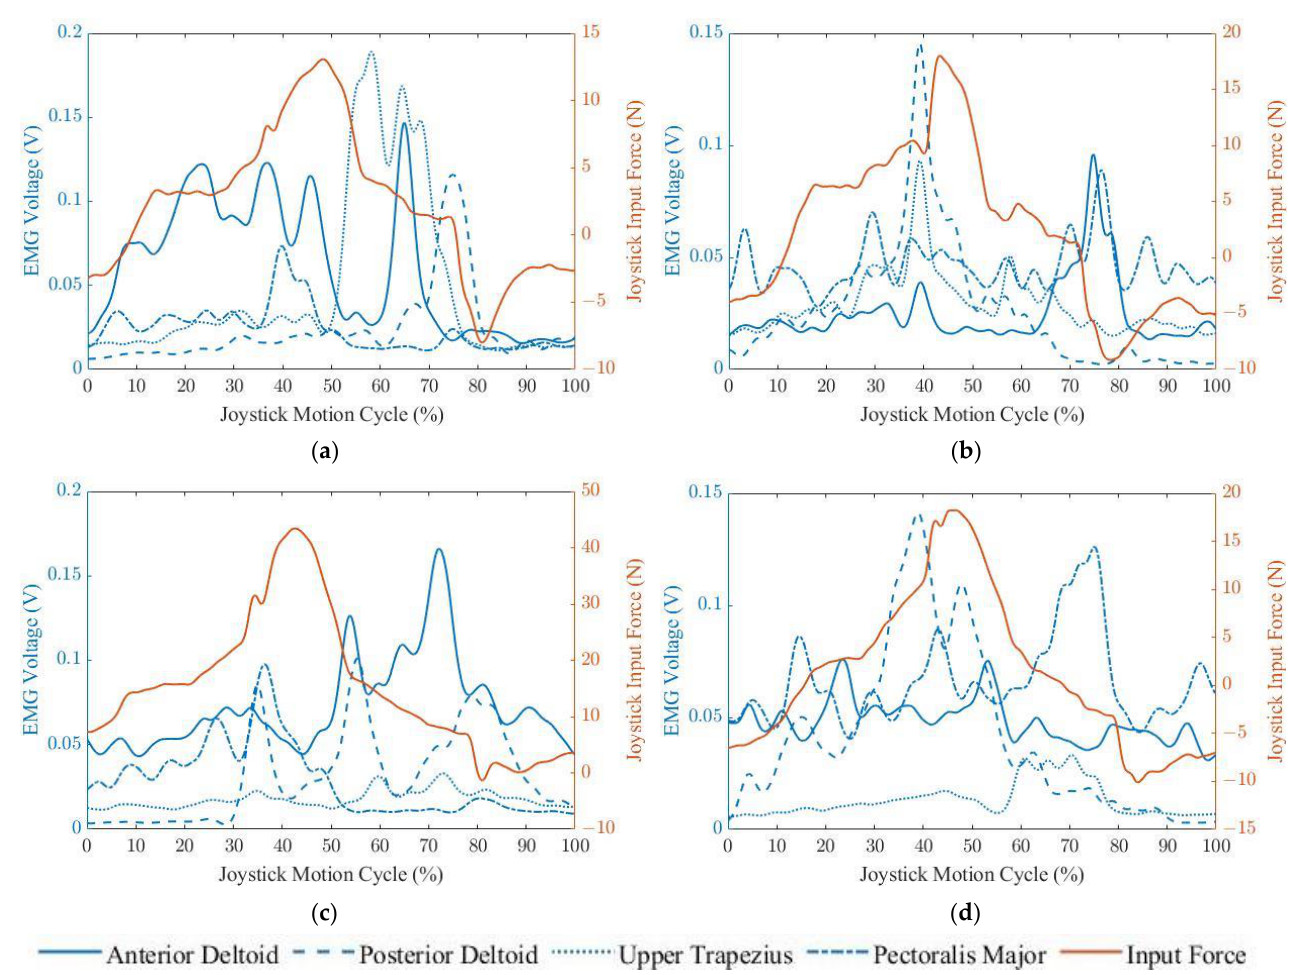
Figure 6. Representative example of muscle activation in the shoulder, neck, and chest, measured by EMG (V) and joystick input force (N) during a representative (1) participant’s fore ( a ), aft ( b ), inward ( c ), and outward ( d ) joystick throws while using the dynamic armrest.